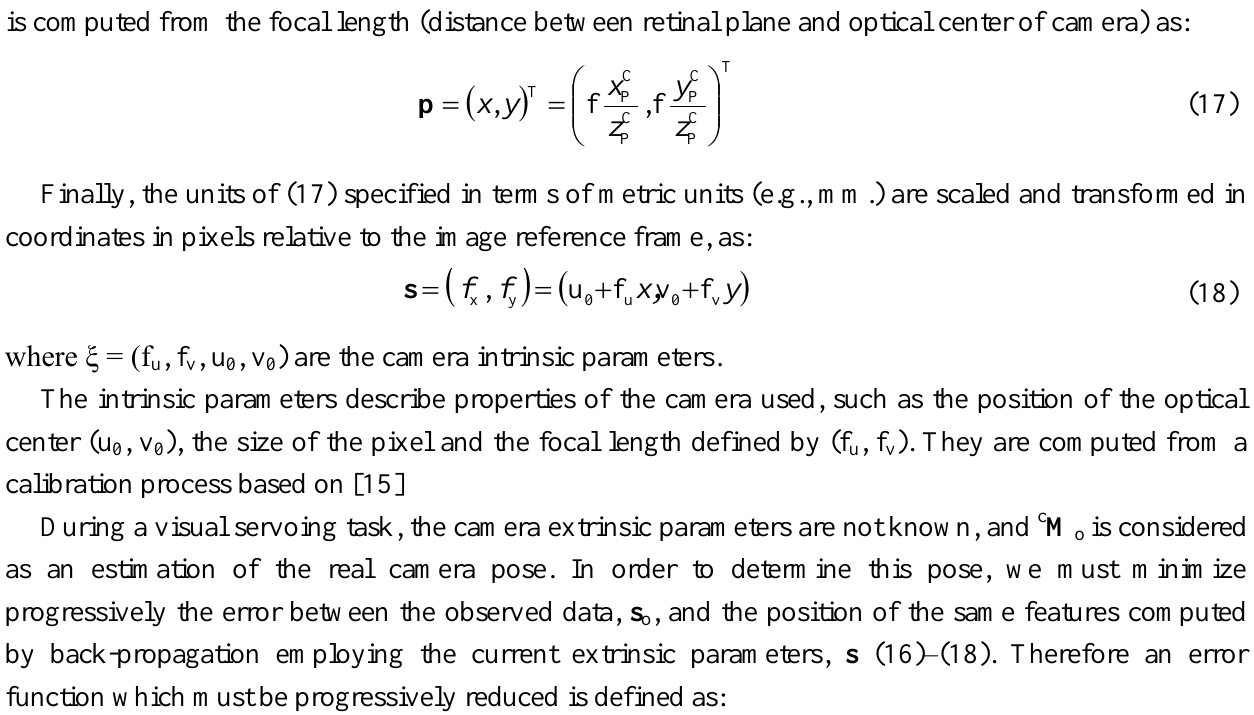
 for distances between 0.3 C z P